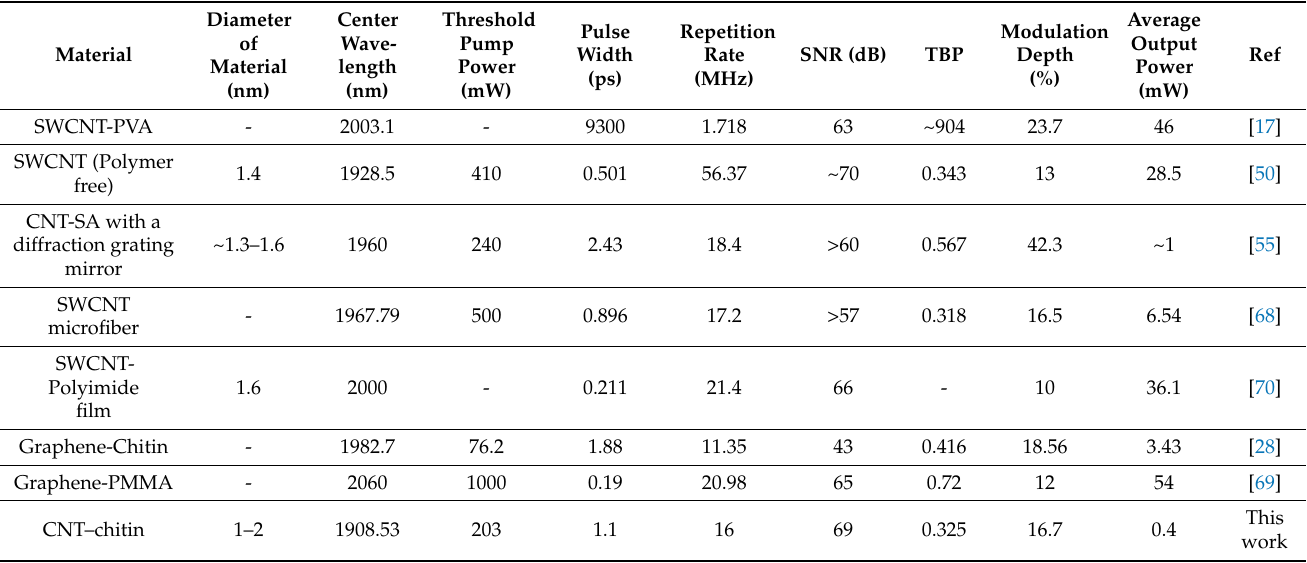
Table 1. Mode − Locker for SA in 2 µ m